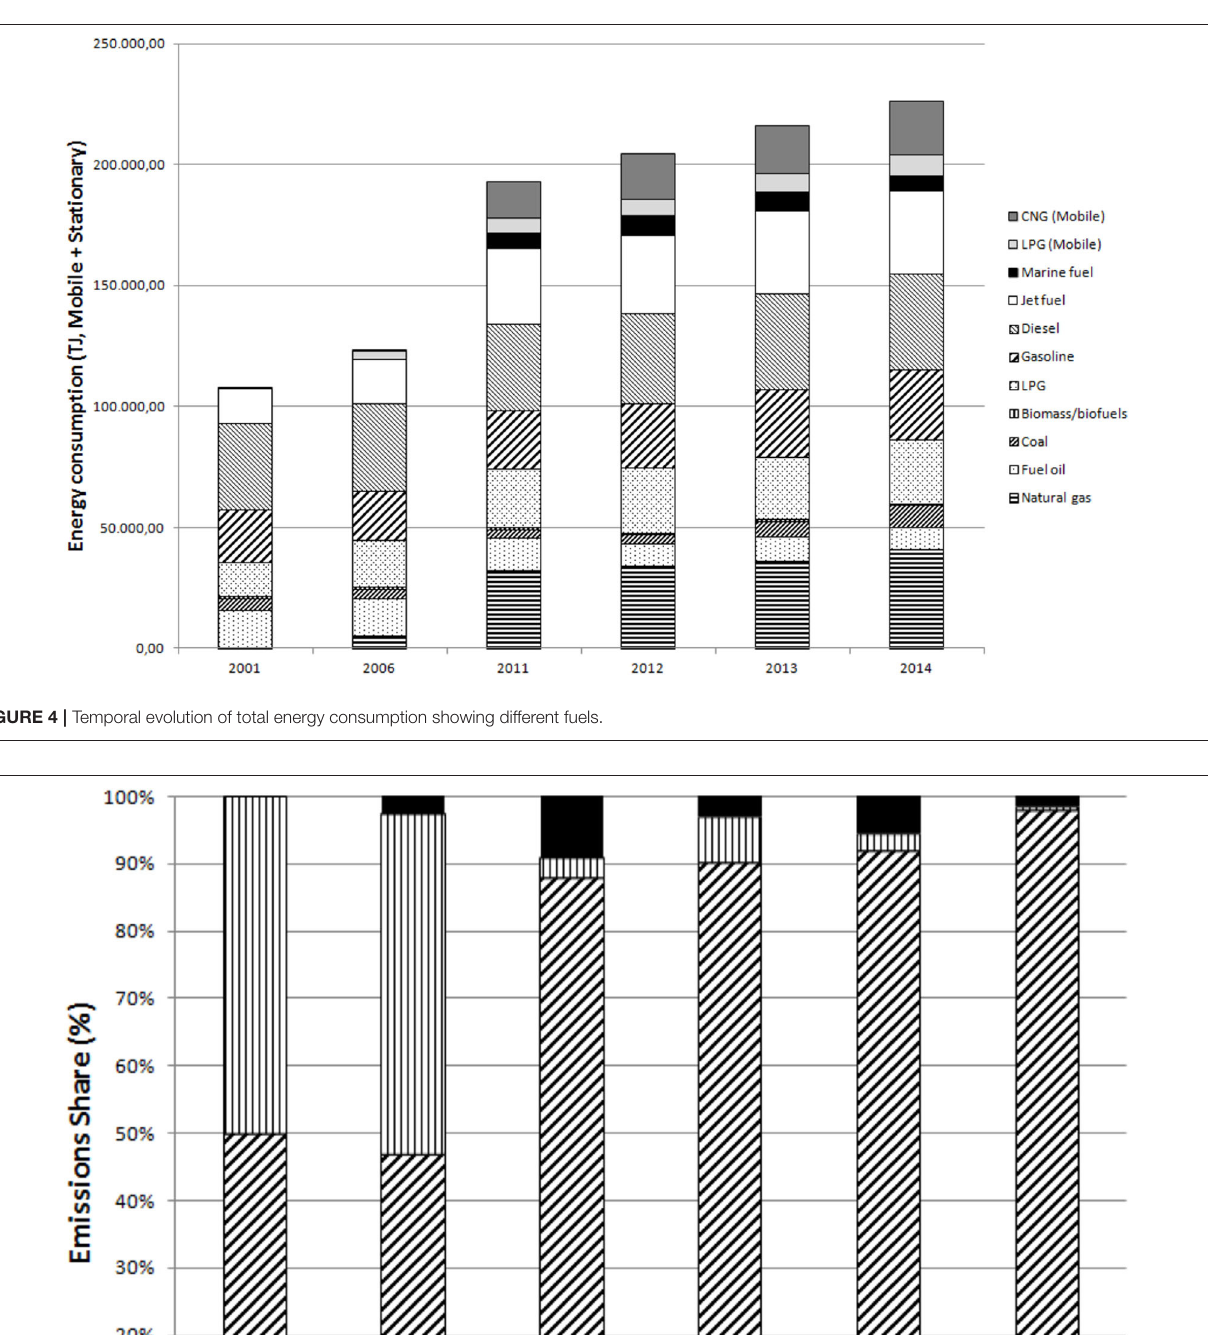
Frontiers in Sustainable Cities |